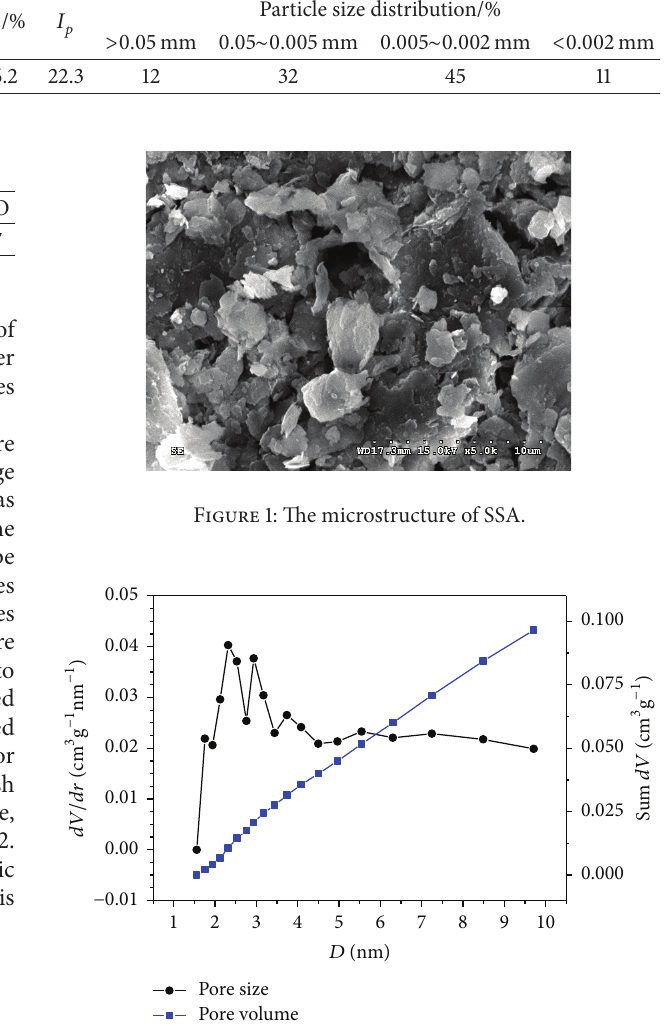
Figure 2: The pore volume and pore size distributions of